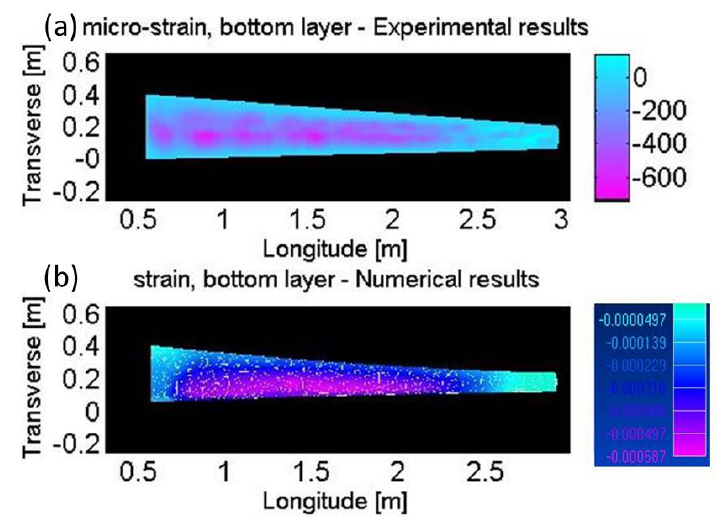
Figure 8. Strain profiles across the lower surface of a composite model wing of an unmanned aerial vehicle, subject to static loading of 550 N. ( a ): strain map extrapolated from high-resolution phase-coded B-OCDA traces. ( b ): predicted strain map obtained by numerical, structural analysis.